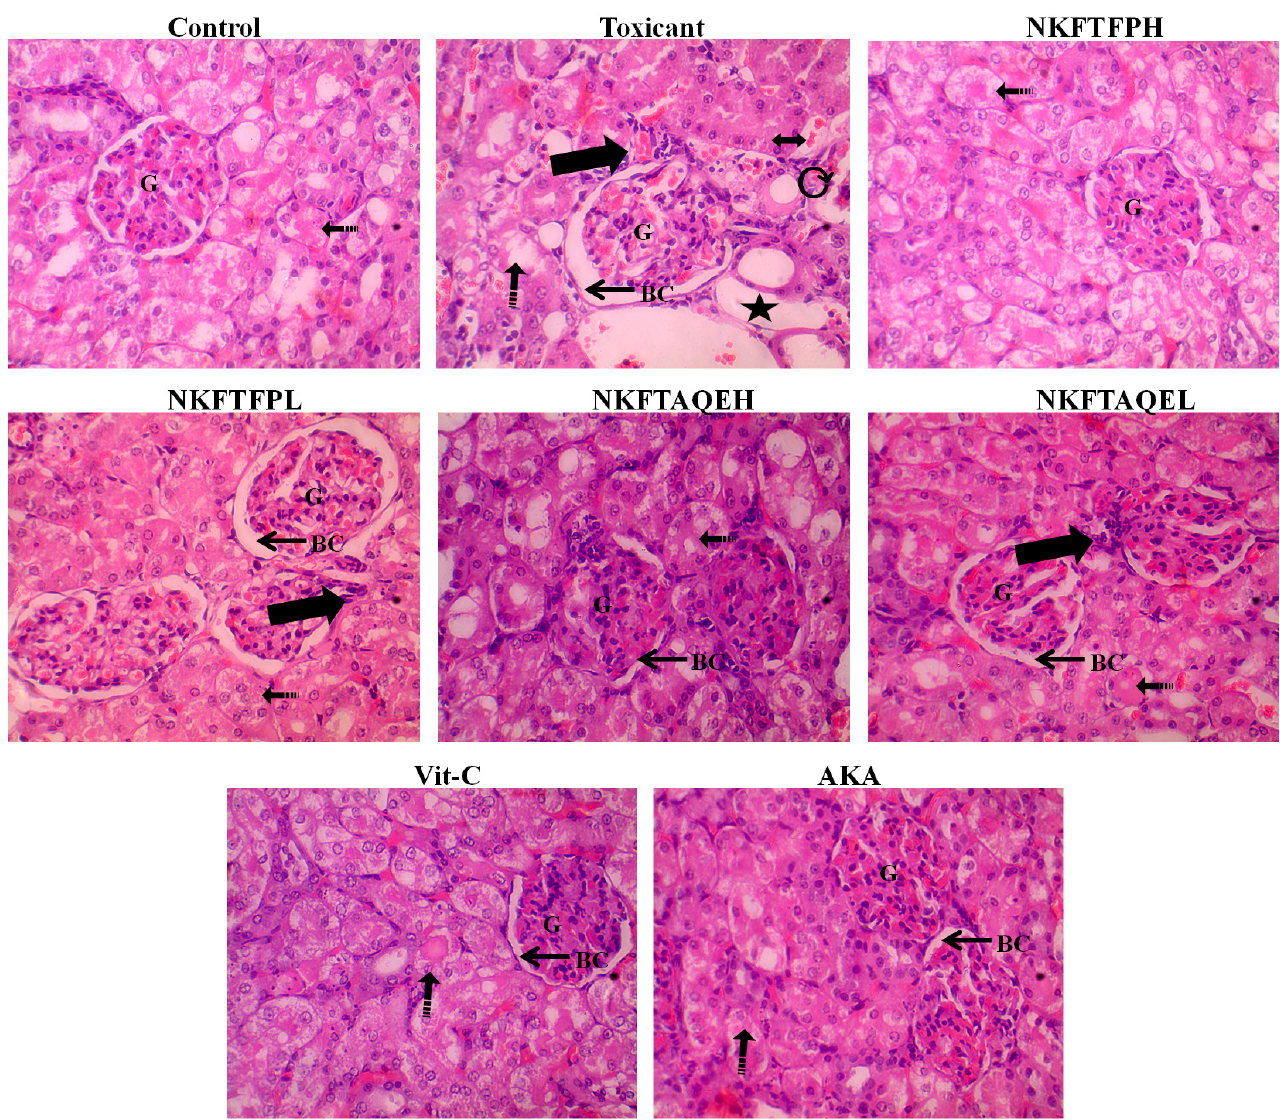
Figure 7. The histopathological section evaluation of the kidney displayed severe inflammatory cell infiltration (thick arrow), irregular dilated Lumina (star), interstitial hemorrhage (dotted arrow), vacuolated cytoplasm and destructured brush border cells (double-sided arrow), atrophy and tubular epithelial injury (curvy arrow), with widened Bowman’s space along with congestion in capillaries of the glomerulus in toxic control group, as compared to the control group.